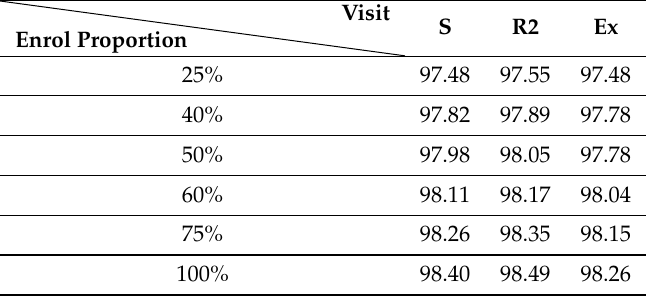
Table 10. Accuracy (%) for different enrolment proportions when using R1 FD for enrolment. Enrol Proportion